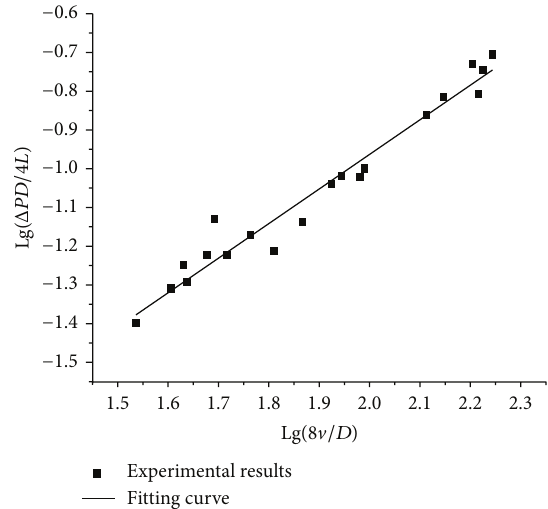
Figure 2: Fitting curve of experimental